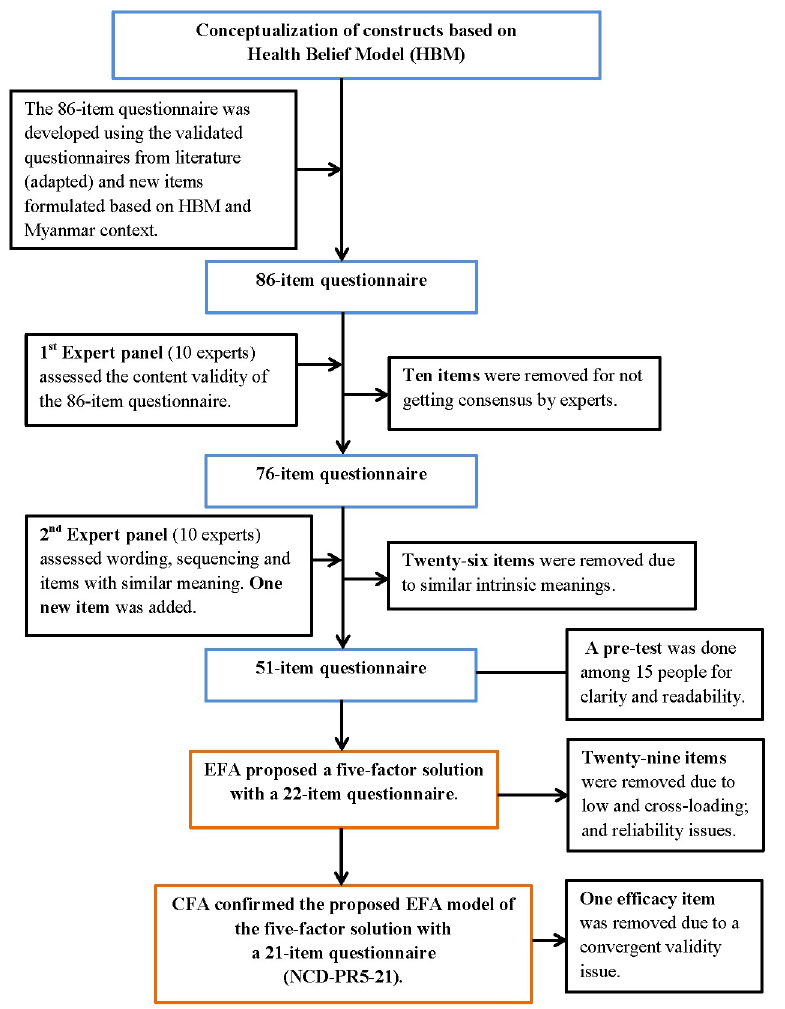
Fig 1. Questionnaire development and validation process flow